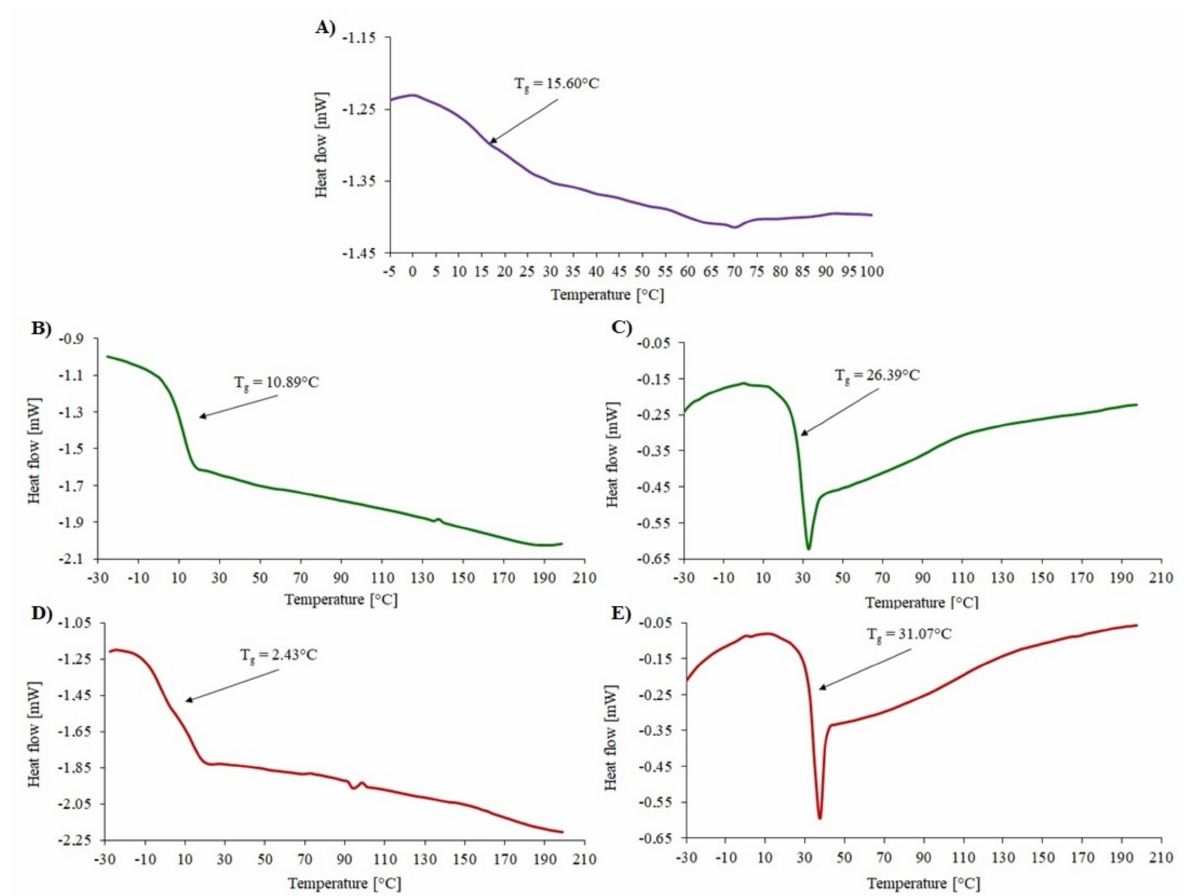
Figure 6. DSC thermogram for MI 2 ( A ), MP2 before ( B ) and after ( C ) degradation and MP3 before ( D ) and after ( E )